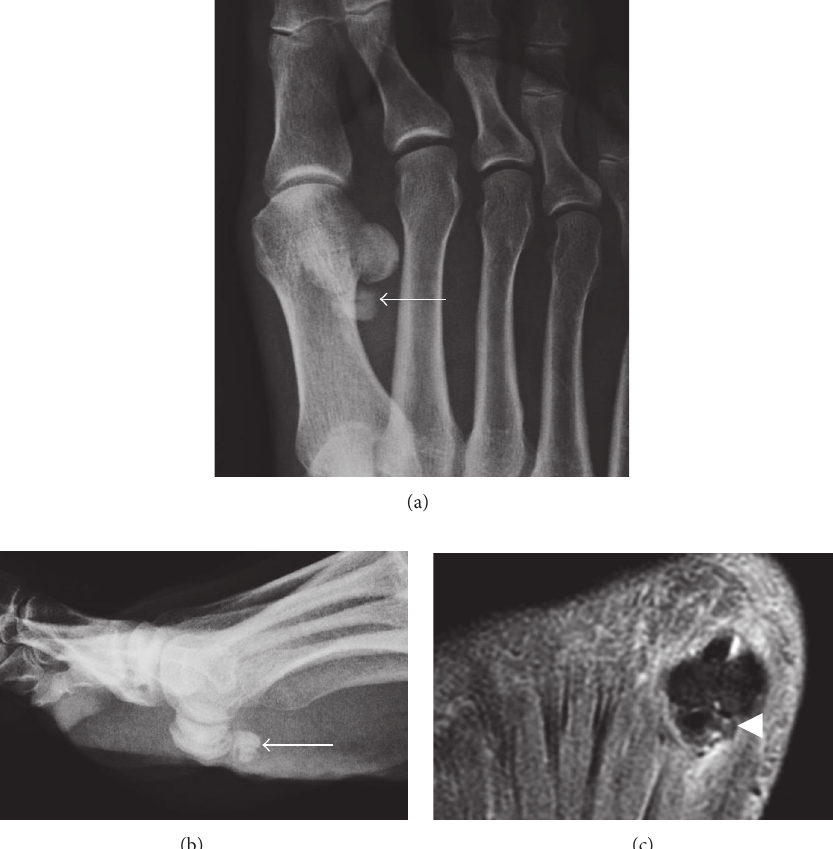
Figure 16: Calcific tendinitis of the flexor hallucis brevis. (a) and (b) Amorphous calcification consistent with acute, symptomatic phase of calcific tendinitis is present just proximal to the hallucal sesamoids (arrows). (c) Long axis PD fat-saturated MR image shows heterogenous signal of the calcification (arrowhead) with mild surrounding edema, which is also consistent with acute symptomatic